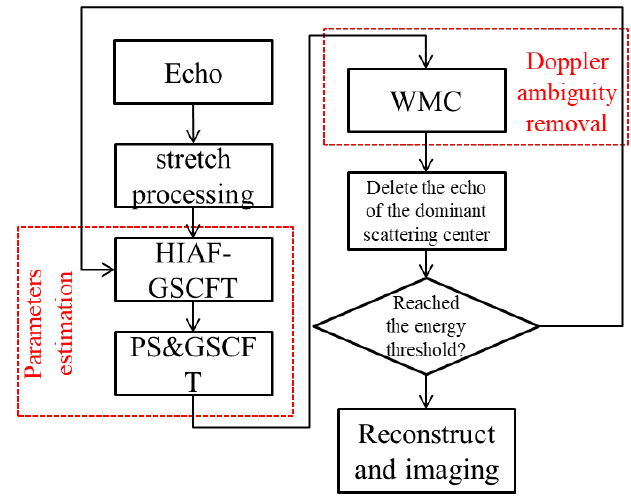
Figure 3. Flowchart of the proposed method.